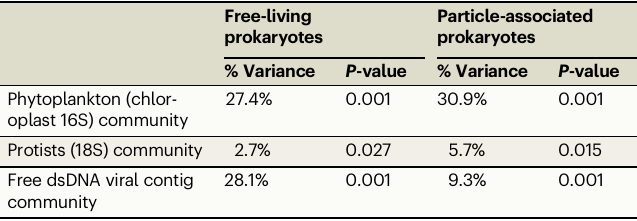
Table 1 | Portion of the variance of free-living and particle- associated or larger prokaryotic 16S community explained by each component after partitioning out the environmental effect (i.e., temperature and chlorophyll-a) using partial CCA